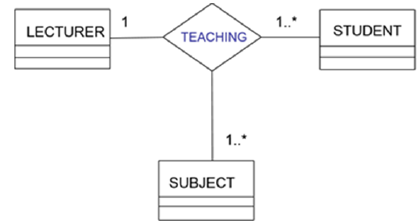
Fig. 3. Example of the ternary association. The optimized diagram is shown in the Figure 4.